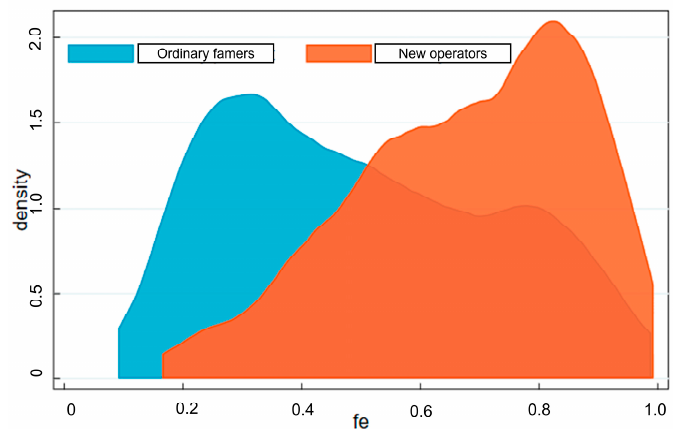
Figure 3. Kernel density distribution of farmers’ fe.